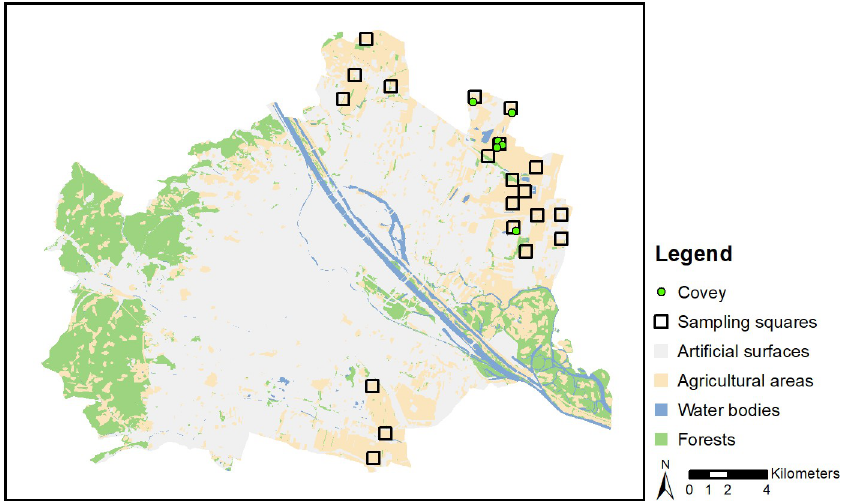
Fig 3. Spatial distribution of coveys ( > 2 individuals) in winter 2017. Covey size varied between 3 and 15 individuals (mean = 7.2 individuals). Artificial surfaces include settlements and infrastructure (e.g., roads). Source Realnutzungskartierung: Stadt Wien - https://data.wien.gv.at.